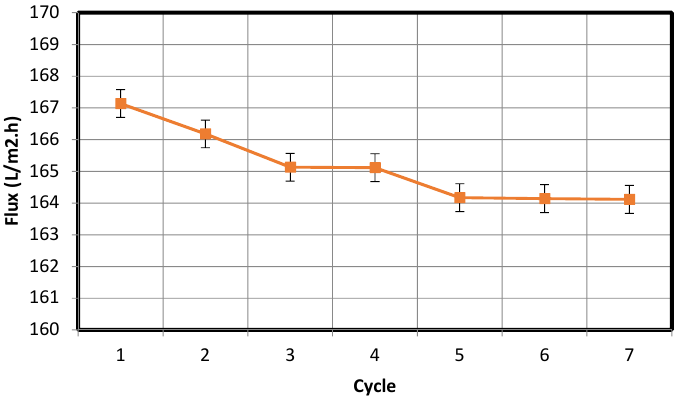
Figure 16. Periodic filtration for the separation of bentonite powder suspended in water.